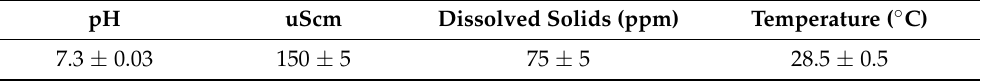
Table A1. Physical and chemical parameters of drinking tape water Cali